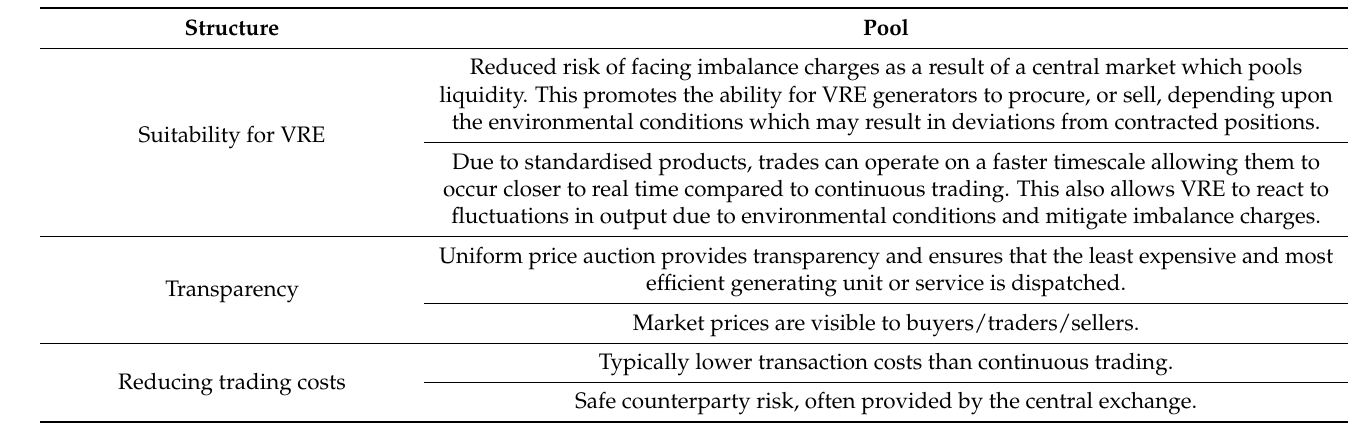
Table 4. The rationale for selecting a pool market as opposed to only